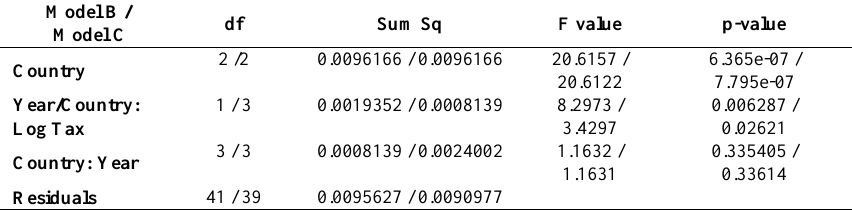
Table 4. Results for adjusted Model B and Model C